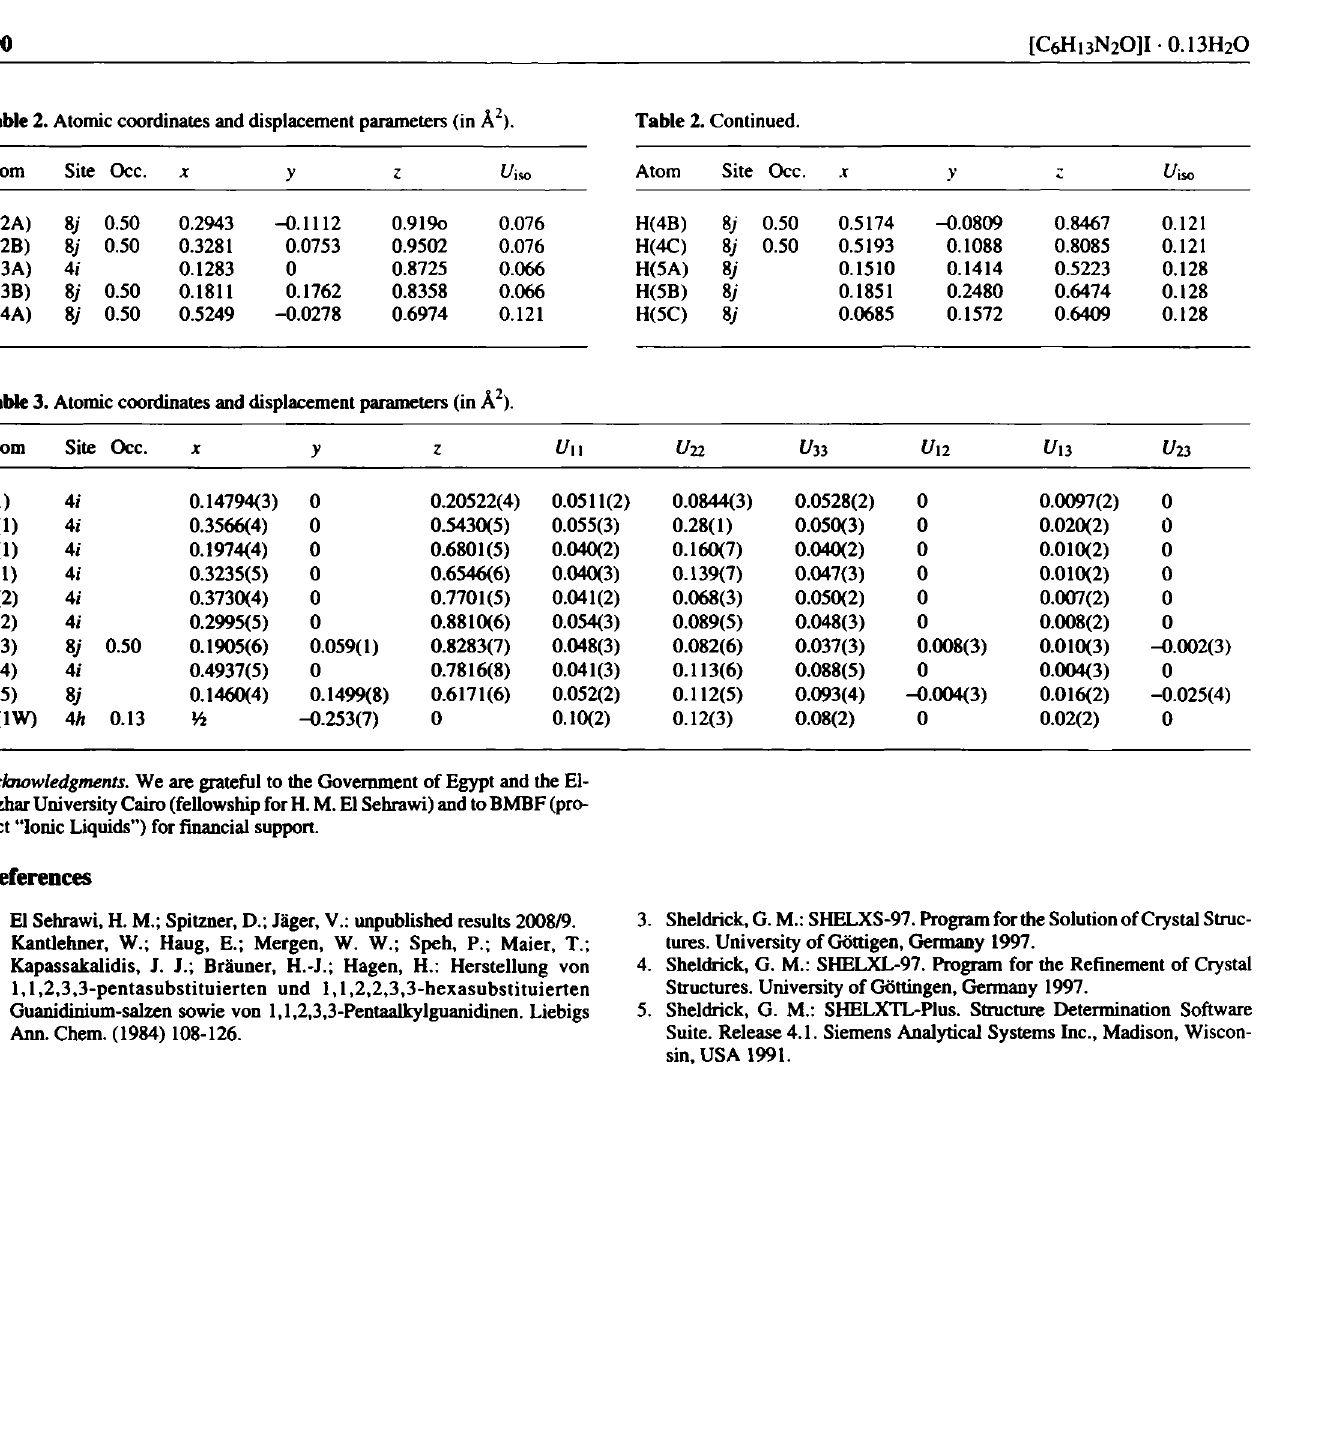
Table 2. Atomic coordinates and displacement parameters (in Â 2 ).